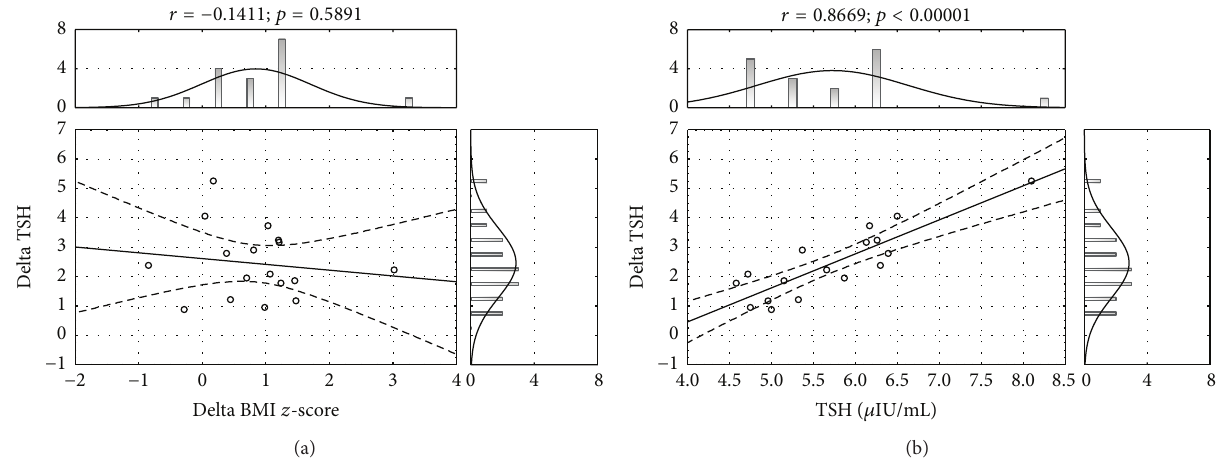
cause of the excessive body weight, and therefore pharmaco- logical treatment should be